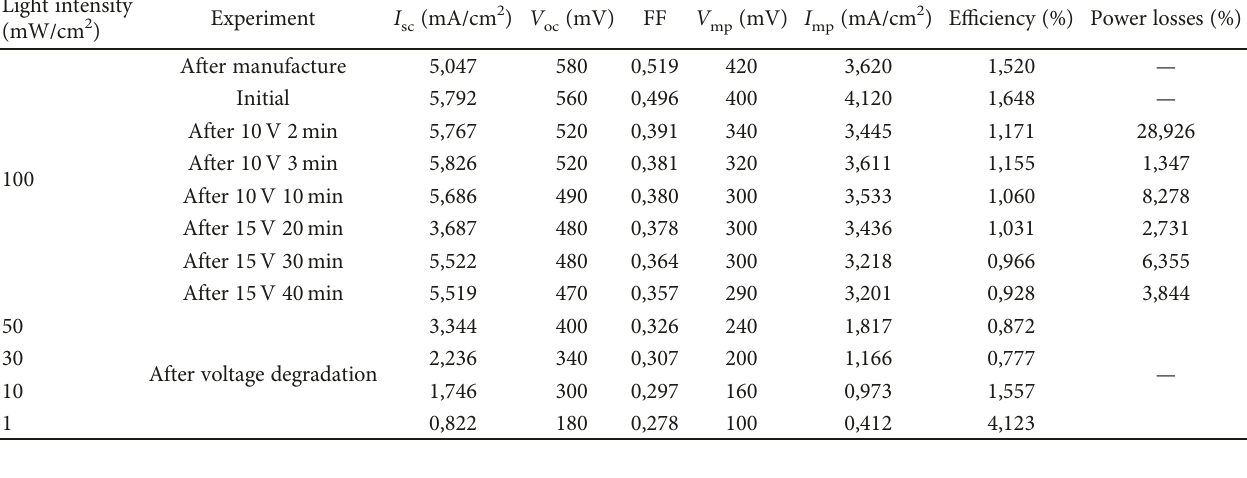
Table 5: Device 5 fi nger 2 time-dependent voltage degradation.